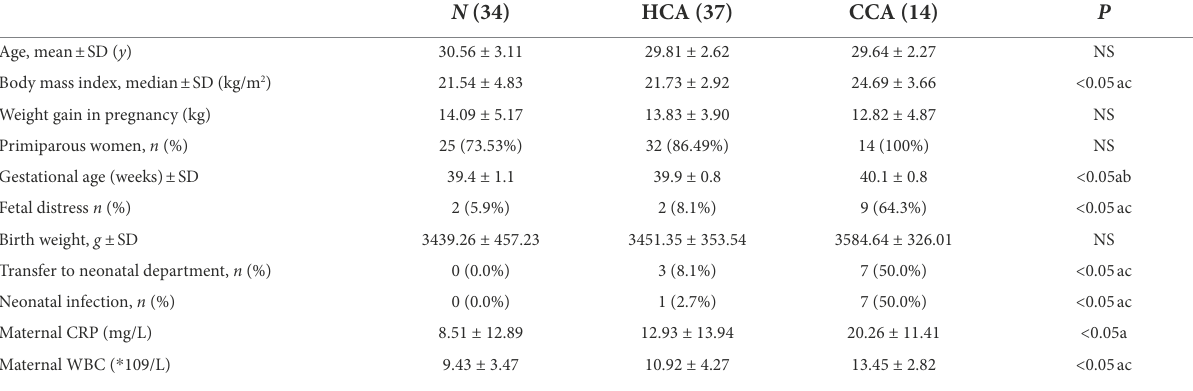
TABLE 2 Characteristics of